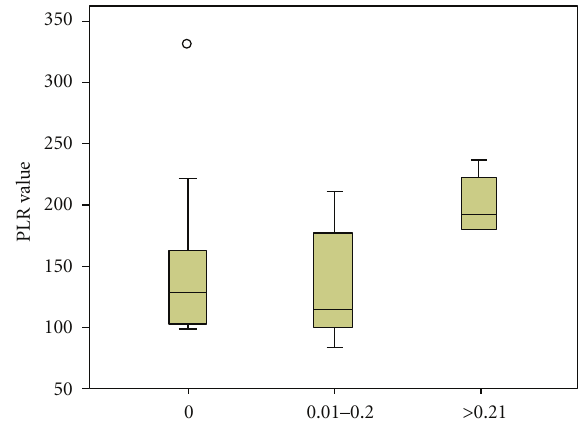
Figure 5: PLR values according to infiltrated/retrieved lymph node ratio value.